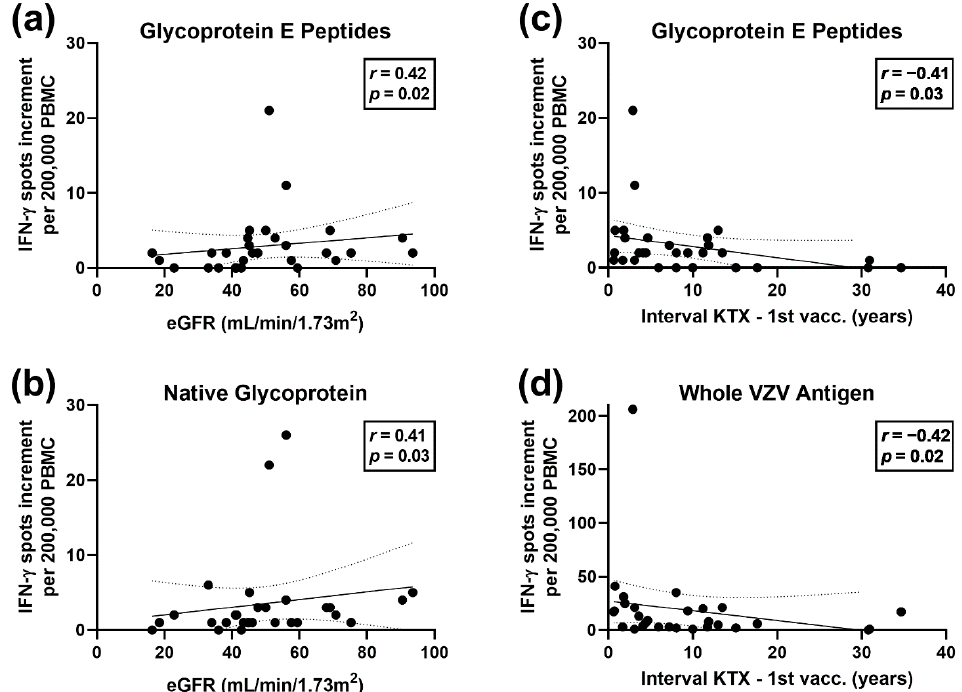
Figure 2. Spearman correlation analysis of estimated glomerular filtration rate (eGFR) or interval between transplantation and first vaccination and ELISpot responses prior to vaccination. In 29 kidney transplant recipients, we observed a positive correlation of eGFR and ELISpot responses towards a peptide pool of glycoprotein E ( a ) and towards the native glycoprotein ( b ). The correlation was negative between the interval between transplantation and first vaccination and ELISpot responses towards a peptide pool of glycoprotein E ( c ), as well as towards whole varicella–zoster virus (VZV) ( d ). The continuous line represents the regression line, and the broken lines represent the 95% confidence interval. Moreover, the interval between transplantation and first vaccination was correlated negatively with baseline ELISpot responses to the gE peptide pool ( r = −0 .41 and p = 0.03) and to the whole VZV antigen ( r = −0 .42 and p = 0.02) (Figure 2c,d). Thus, patients tested early after transplantation showed higher VZV-specific cellular responses.